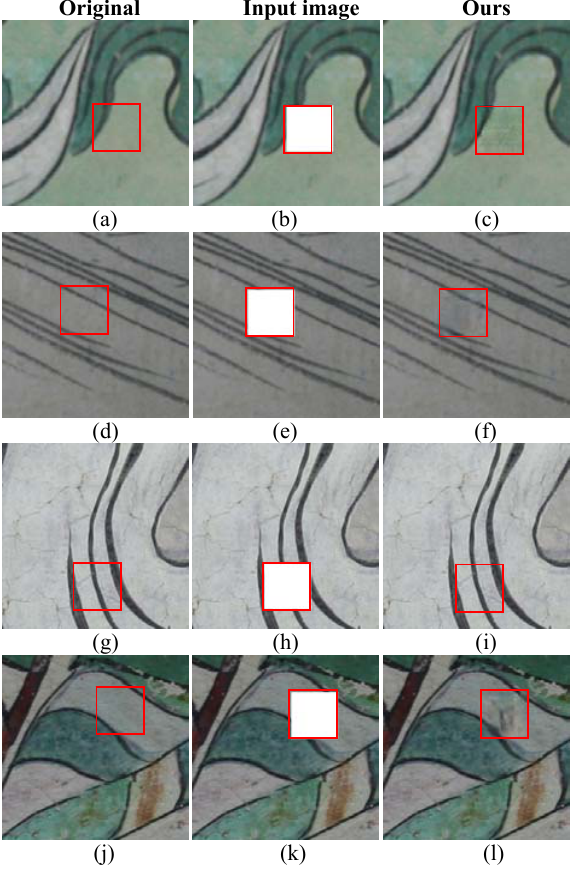
Figure 8 . Visual results on dataset